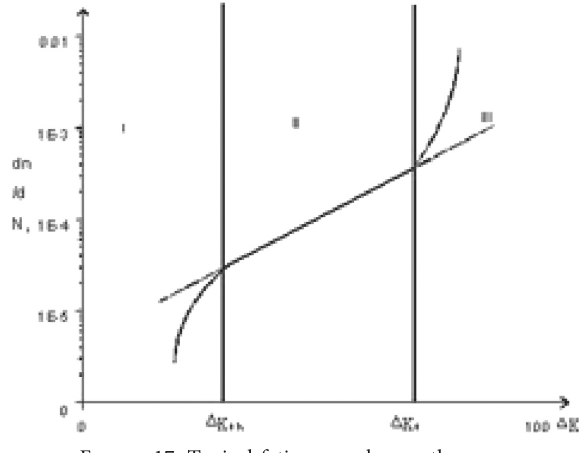
Figure 17: Typical fatigue crack growth